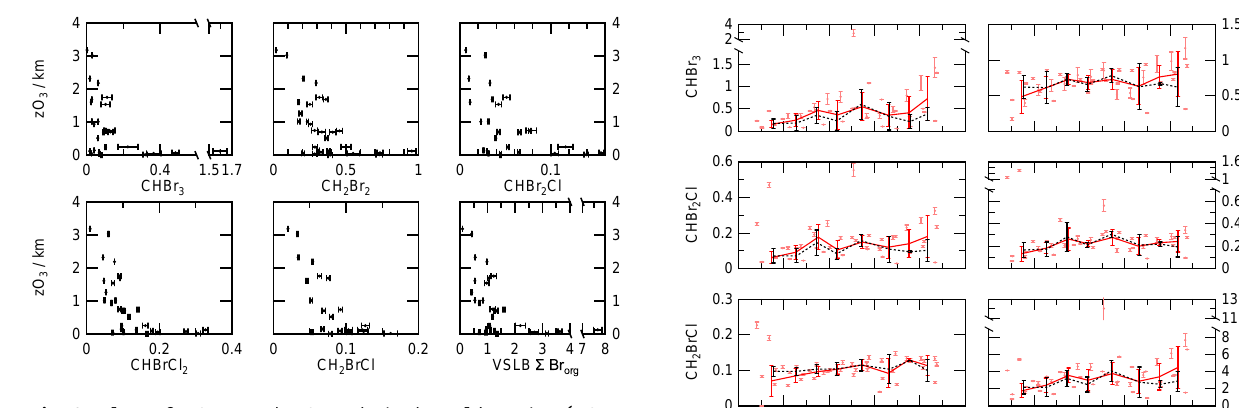
Fig. 6. Plots of VSLB and VSLB-derived total bromine (VSLB 6 Br org ) for Central American flights with O 3 -derived height above the thermal tropopause (zO 3 ) as defined by Zahn and Bren- ninkmeijer (2003). Error bars represent analytical uncertainties. The tropopause is defined as zO 3 = 0 (see Sect. 3.1.3). All VSLB values on the horizontal axes are given in ppt.